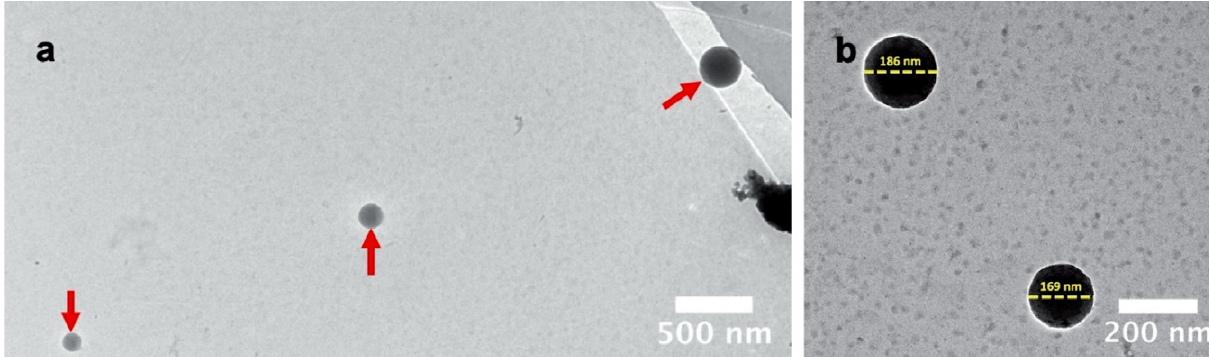
Figure 5 . Low resolution TEM images of P-P-3 sample, a) an array of particles with different sizes b) two random PEGMA particles with similar